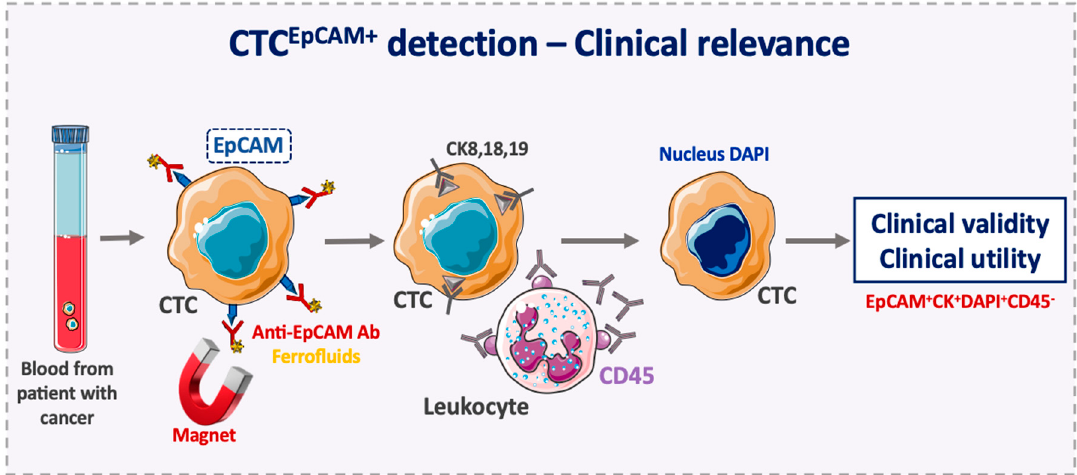
Figure 1. Use of the epithelial cell adhesion molecule (EpCAM) to detect clinically relevant circulating tumor cells. In the FDA-cleared CellSearch ® system, circulating tumor cells (CTCs) are enriched positively using ferrofluid nanoparticles coated with anti-EpCAM antibodies that bind to EpCAM-positive CTCs. Then, CTCs are selected using anti-CK8, -CK18, and -CK19 antibodies and DAPI nuclear staining. Leukocytes are excluded using anti-CD45 antibodies. CTC, circulating tumor cell; CK, cytokeratin; Ab, antibody; EpCAM, epithelial cell adhesion molecule.